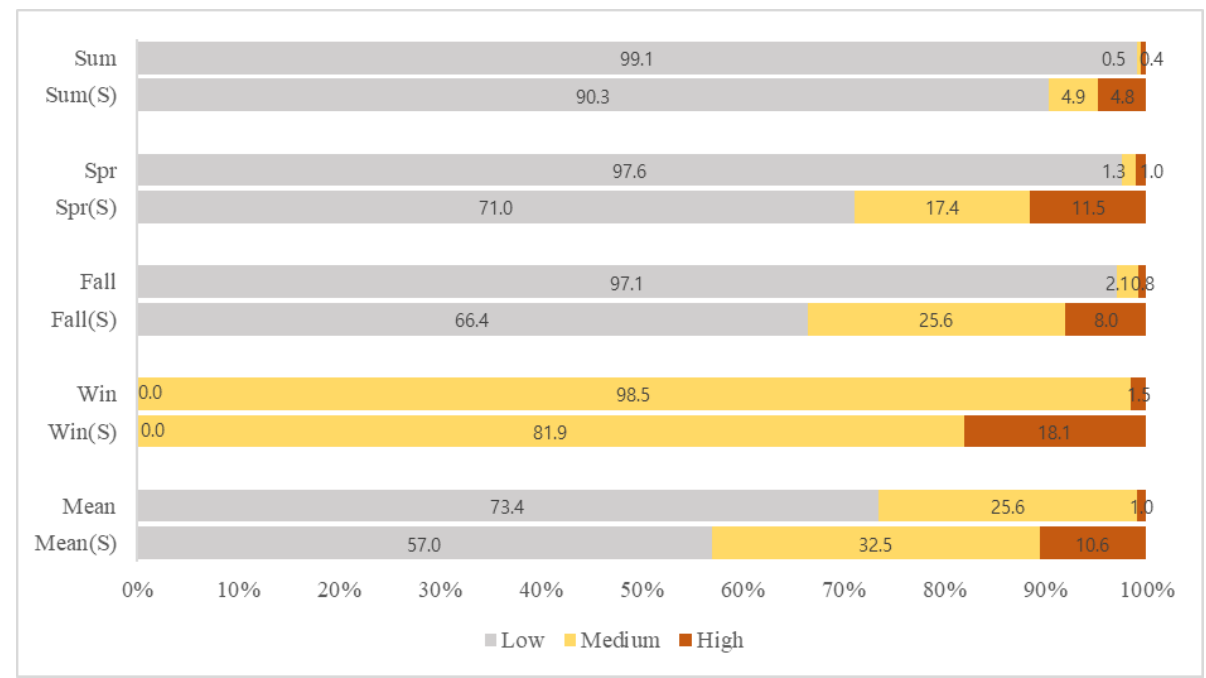
Figure 4. Mean and Seasonal present NO 2 concentration level comparison at Metropolitan area and Seoul capital city (S = Seoul).